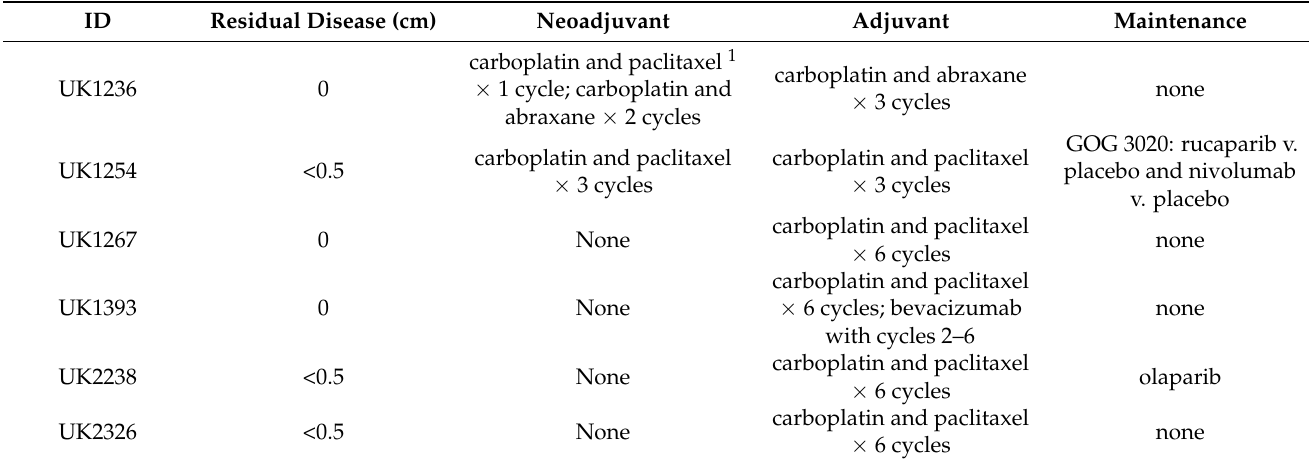
Table 2. Treatment courses of enrolled